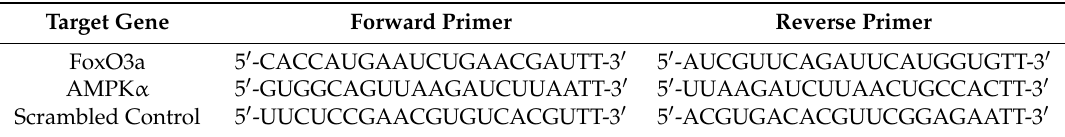
Table 1. Sequences of small interfering RNA used in transfection.